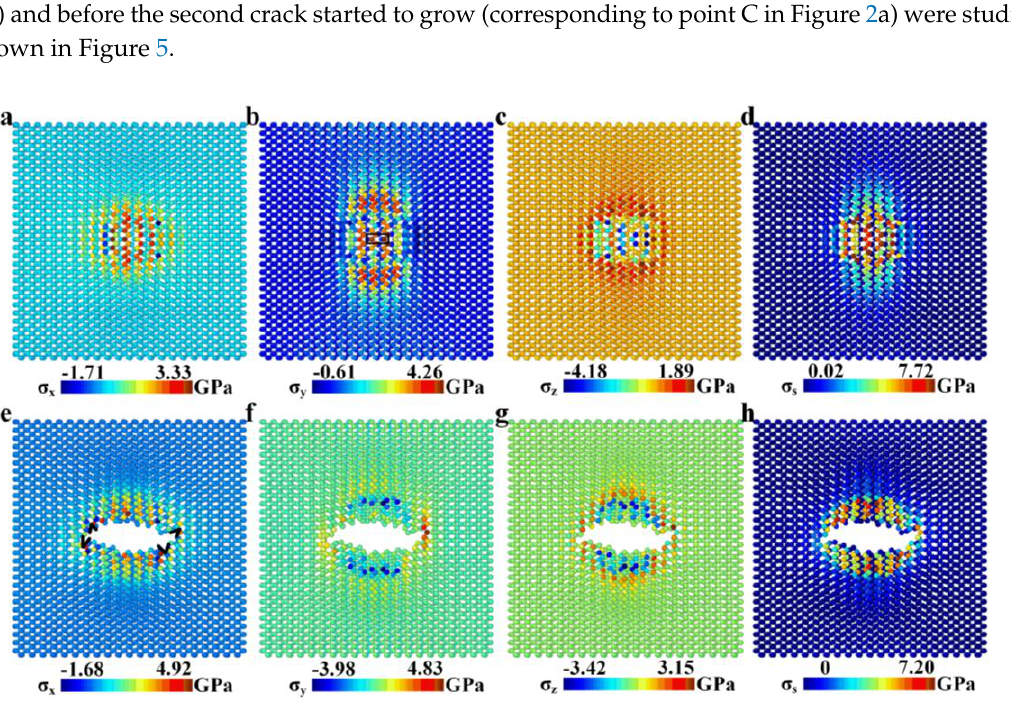
Figure 5. ( a – d ) Distribution of σ x , σ y , σ z and σ s in the freestanding BP monolayer before the